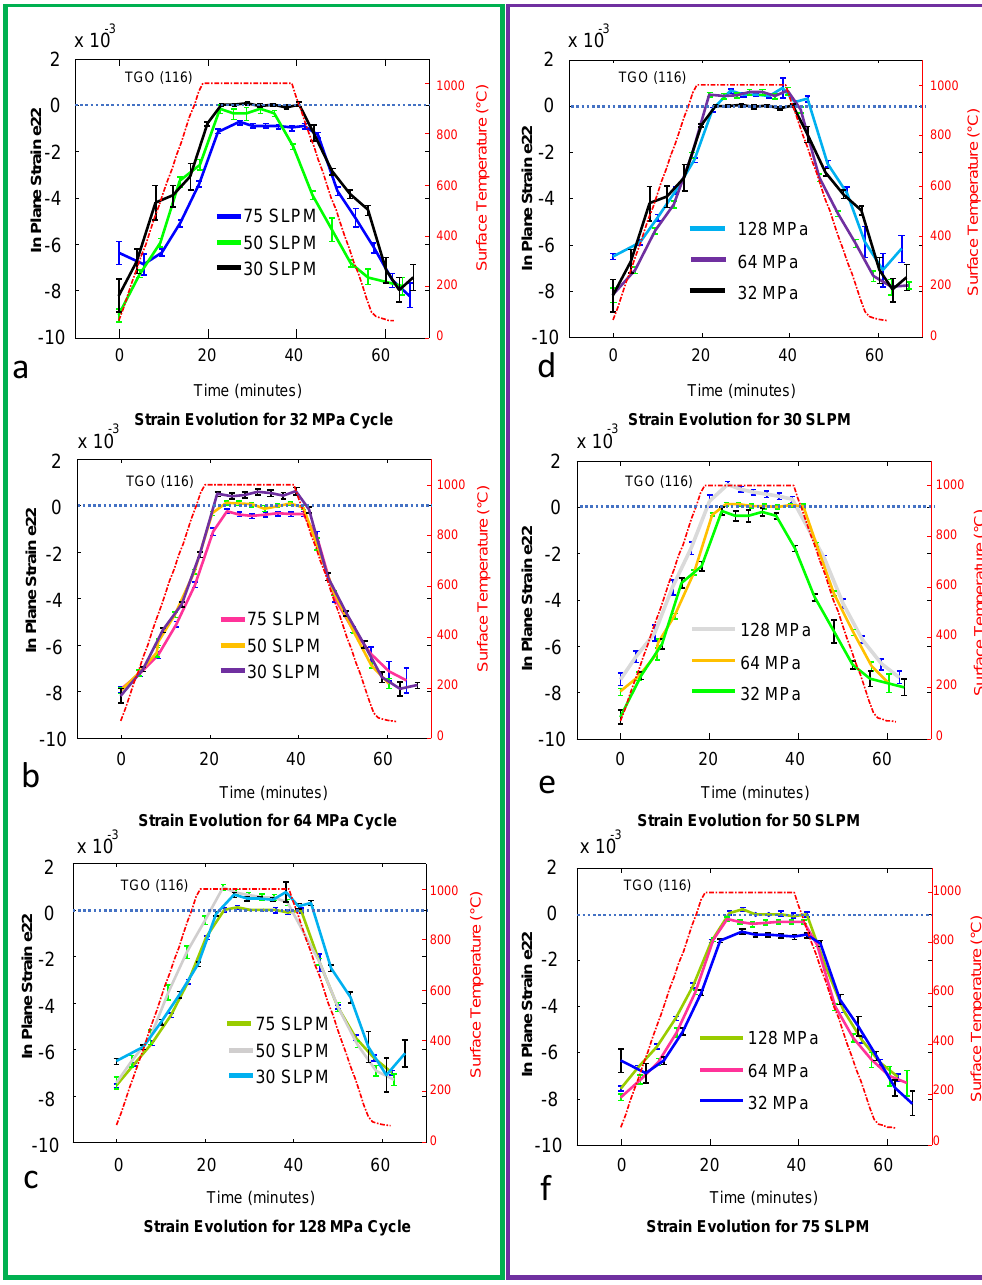
Figure 2. TGO e22 strain response over thermal cycle for constant mechanical load with varying flow ( a – c ); and replotted to show constant flow with varying mechanical loading ( d – f